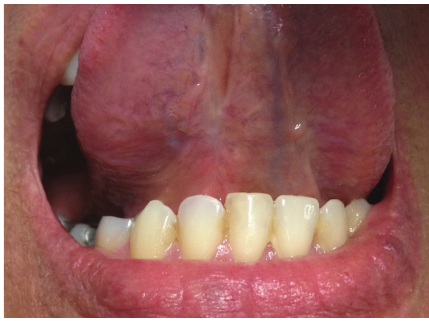
Figure 4: Postoperative of 6 months showing no clinical signs of recurrence of the